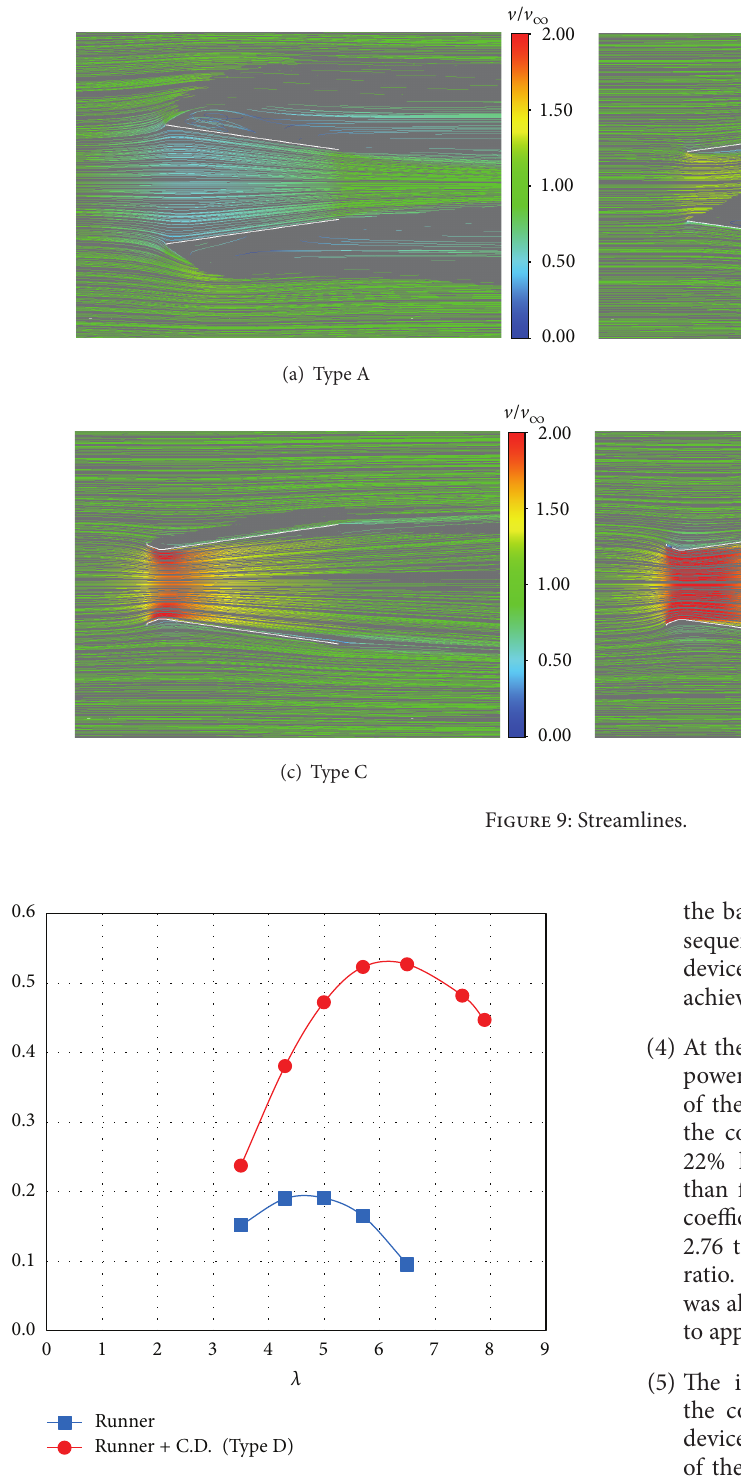
Figure 10: Correlation between the tip speed ratio and the power